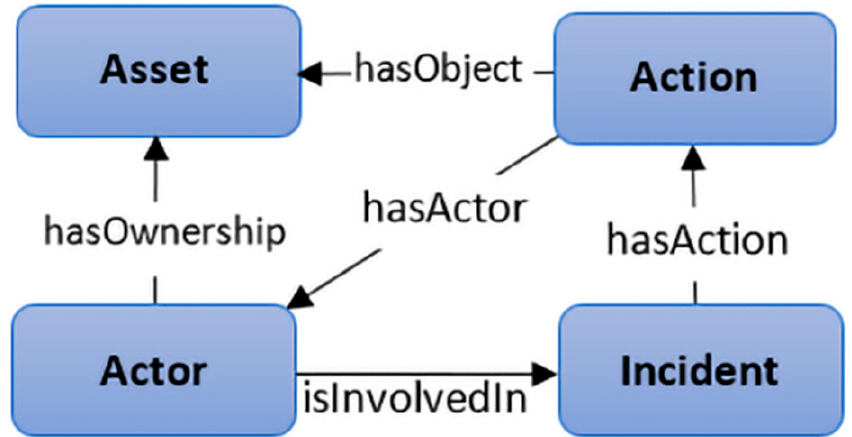
Figure 3. The top-level ontology classes and object properties.